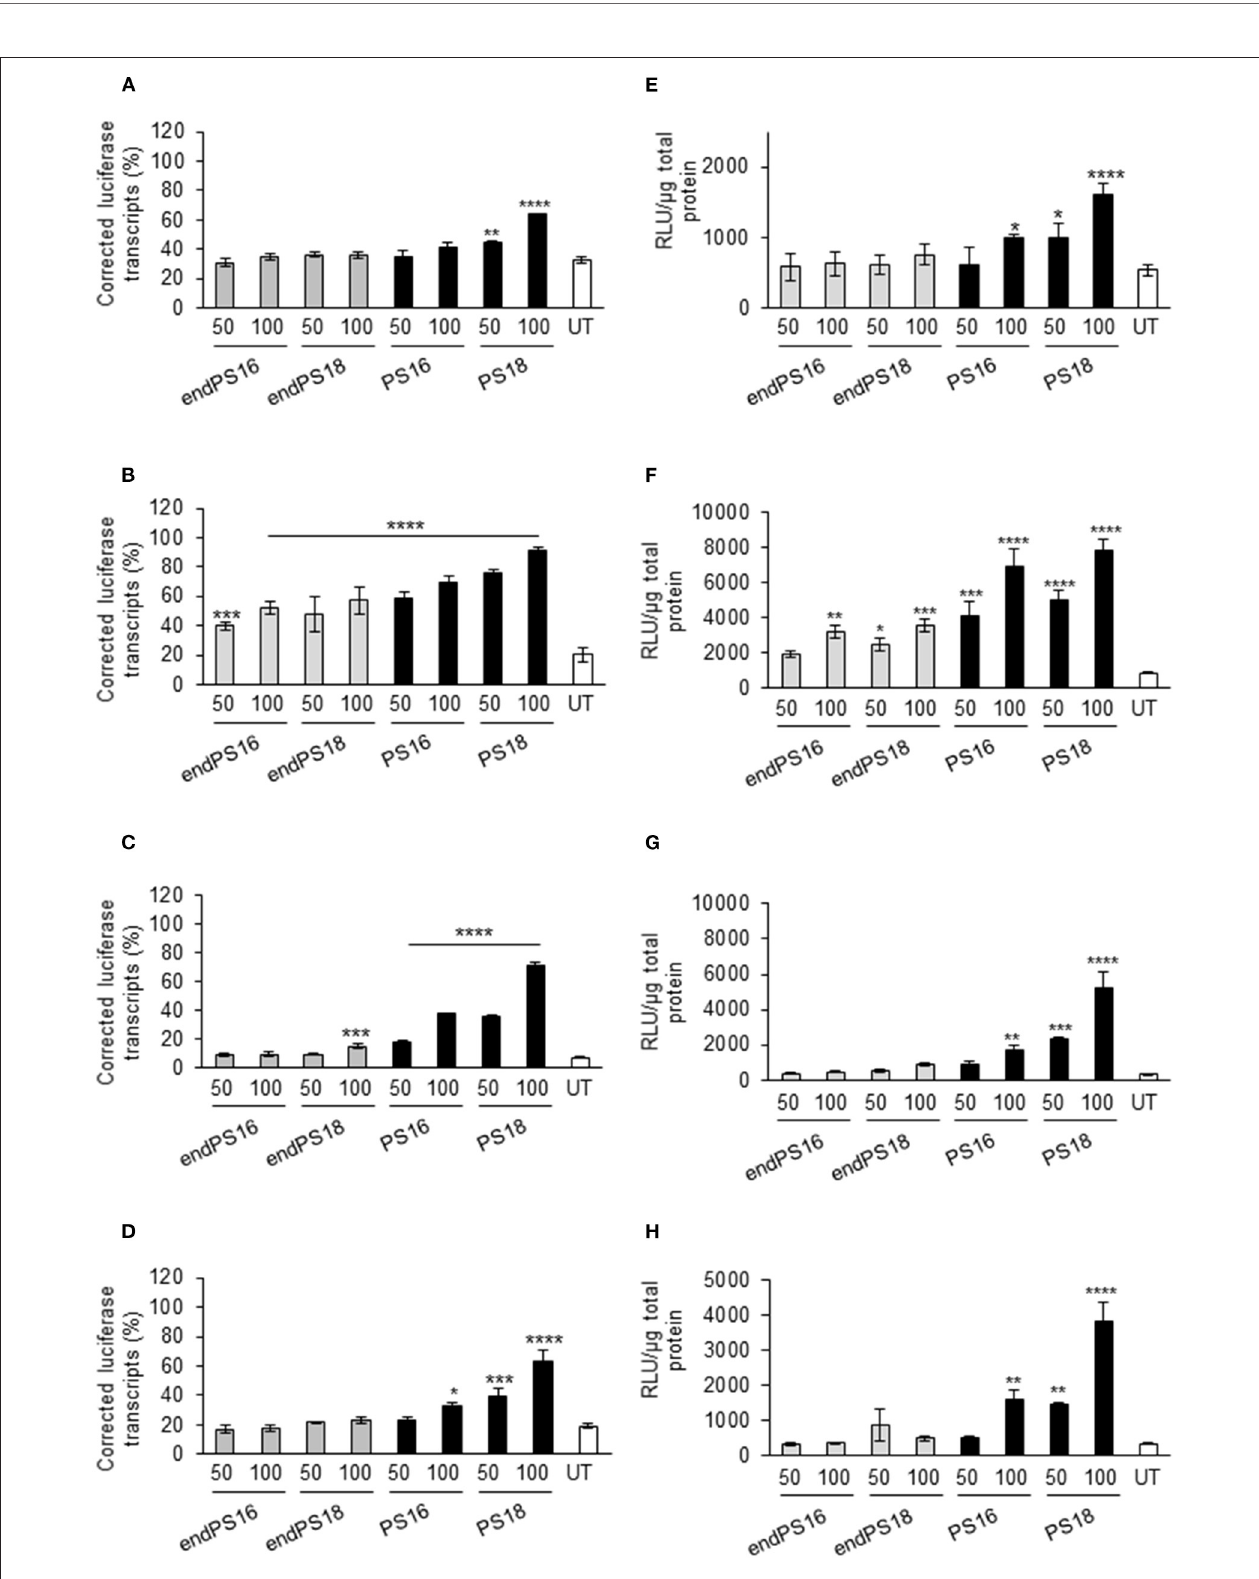
FIGURE 1 | Phosphorothioate (PS) modification modulates the splice-switching activity in different cellular models. Reverse transcription PCR of aberrant and correct luciferase mRNA and 18S RNA in all reporter cell lines when the concentrations of 50 and 100nM of 18 or 16 mers were modified with full PS vs. endPS 2OMe